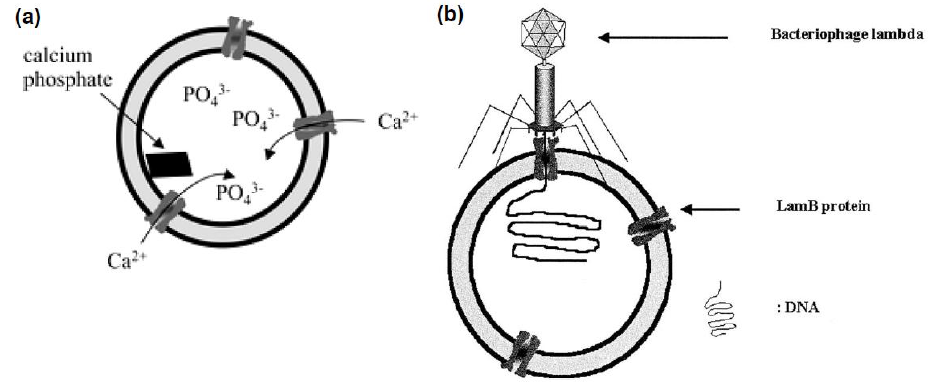
Figure 6. Schematic representation of ( a ) ion-carrier controlled precipitation of calcium phosphate [89], reproduced by permission of the Royal Society of Chemistry, and ( b ) DNA-loading of PMeOx-PDMS-PMeOx block copolymer vesicles [90], reproduced by permission of the National Academy of Sciences